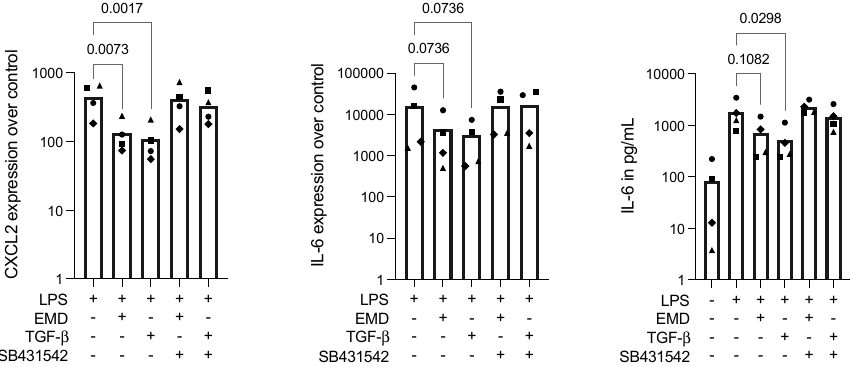
Figure 3. Gene expression of CXCL2 and IL-6 and IL-6 protein secretion in RAW 264.7 cells under LPS stimulation. EMD and TGF- β significantly reduced CXCL2 expression and showed a trend in reducing IL-6 expression and secretion in LPS-stimulated RAW 264.7 cells. SB431542 reversed the reduced effect provoked by EMD and TGF- β . Each data point represents an independent experiment. To compare groups, Friedman test followed by Dunn’s multiple comparison tests on the relevant groups were applied. Table 1. Gene expression of IL-6 (fold expression over control) in primary macrophages under LPS stimulation. EMD reduced IL-6 expression provoked by LPS stimulation in primary macrophages. SB431542 reversed the effect provoked by EMD, bringing up the IL-6 expression levels. 2.4. EMD Attenuates the Nuclear Translocation of Smad2/3 in RAW 264.7 Macrophages LPS Considering that TGF- β stimulates Smad2/3 phosphorylation, [28] we sought to eval- uate if EMD could activate the TGF- β -related Smad2/3 signalling pathway. Then, we stim- ulated RAW 264.7 cells with EMD or TGF- β , in combination or not with the SB431542. SB431542 alone was also applied as a control. Immunofluorescence images revealed that EMD and TGF- β attenuated the nuclear translocation of Smad2/3, and this effect was re- versed in the presence of SB431542 (Figure 4). This is further indication that EMD’s anti- inflammatory properties are mediated via TGF- β signalling.